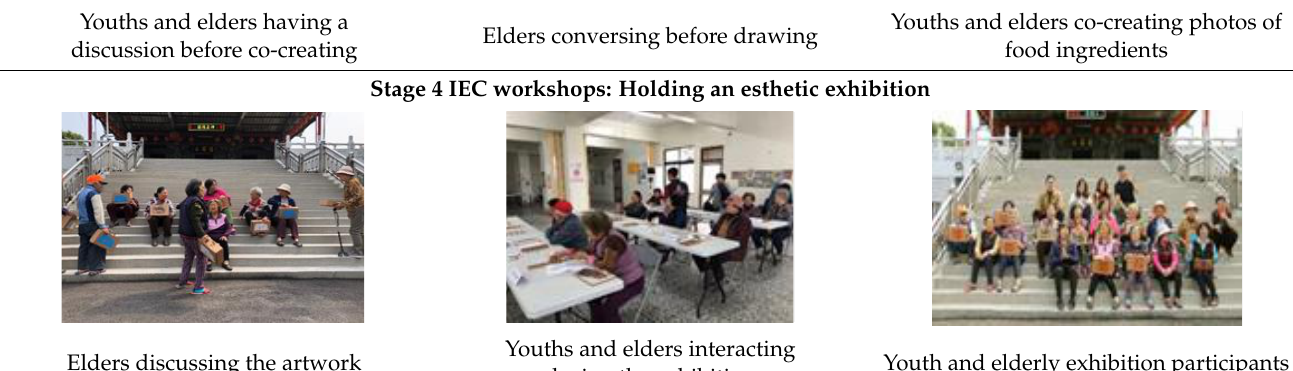
Figure 1. Creations from the Stage 1 IEC workshops. ( a ) S erigraph “ Fangsongtou old well ” (by E6- C-Week06). In Taiwanese Hokkien, Fangsongtou means “to broadcast using a loudhailer”. The well was named Fangsongtou because it was an important site for information transmission. The elders used to go there to fetch water and do their washing. It was also a playground for children. The community residents recalled the site as a locale for exchanging pleasantries and catching one an- other up about their current situation and interesting news. ( b ) S erigraph “ Great- grandparents’ old house ” (by E14-C-Week06). This used to be the residence of a senior who was quite advanced in age. It was built using only tenon joints between bamboo tubes, showcasing high-precision crafts- manship. The internal layout and consideration of daily necessities reflect the life trajectory and historical backdrop at that time. ( a ) ( b ) Figure 2. Creations from the Stage 2 IEC workshops. ( a ) Cyanotype under the theme “Tribute to the youthful years” (E2-C-Week12). Photographs of an elder when he was a youth were transformed into cyanotypes, which triggered smiles while recalling the brilliance of life. ( b ) Cyanotype under the theme “Tribute to the youthful years” (E6 -C-Week12). A photograph of an elder when she was a youth was transformed into a cyanotype that showcases the luminance and vitality of life.